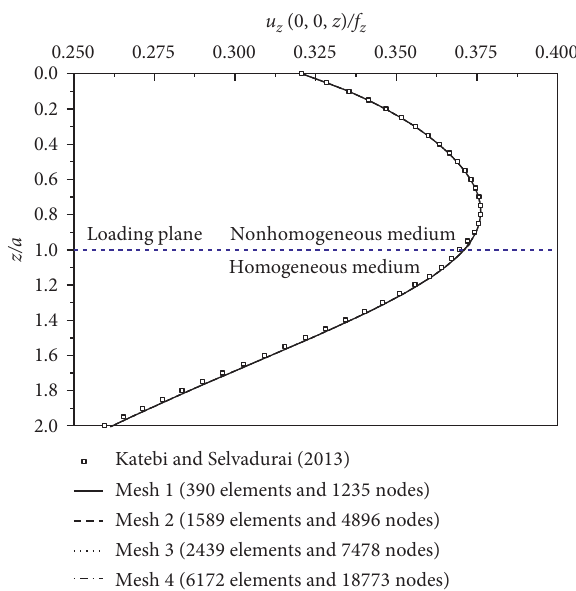
Figure 5: Variation of the displacement u meshes.